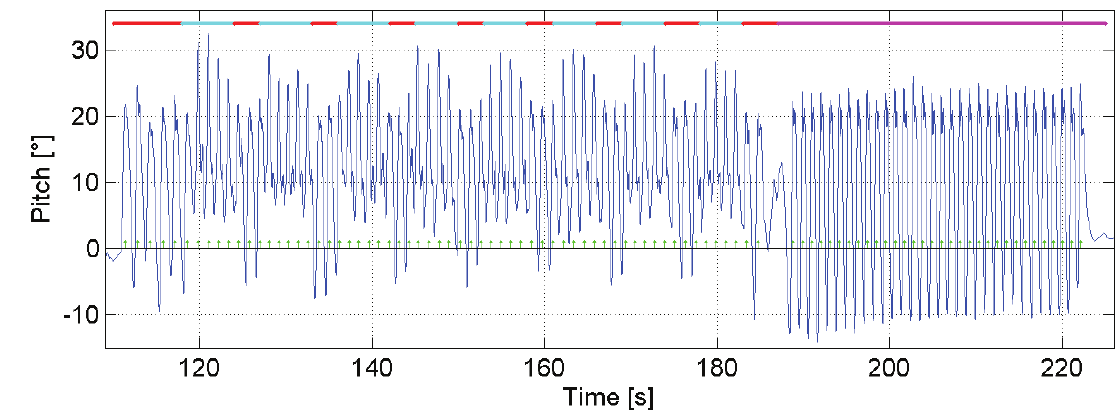
Figure 10. Pitch angle estimation of the scenario Downstairs. The green dots represent the truth of the taken steps. The upper colored line maps different zones of the walk: red for the landing zone of the staircase, cyan for the stairs and magenta for the